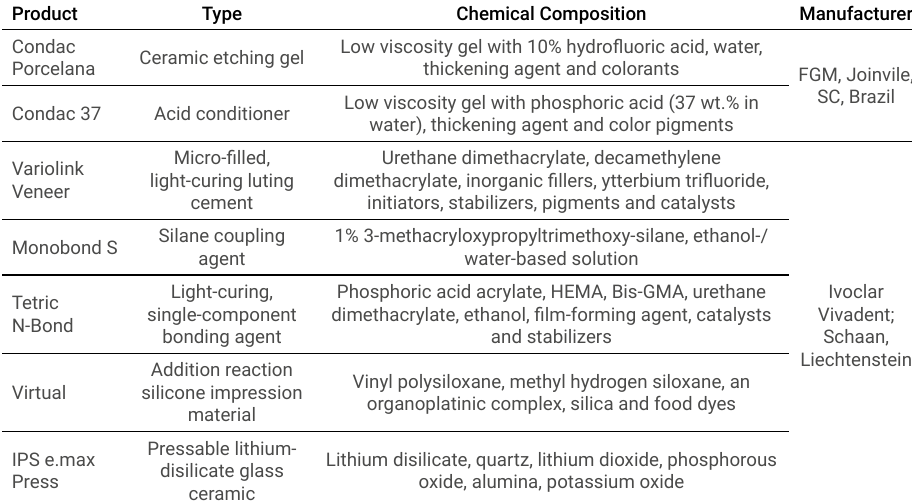
Figure 3. Manufacturers and chemical compositions of the materials used in the